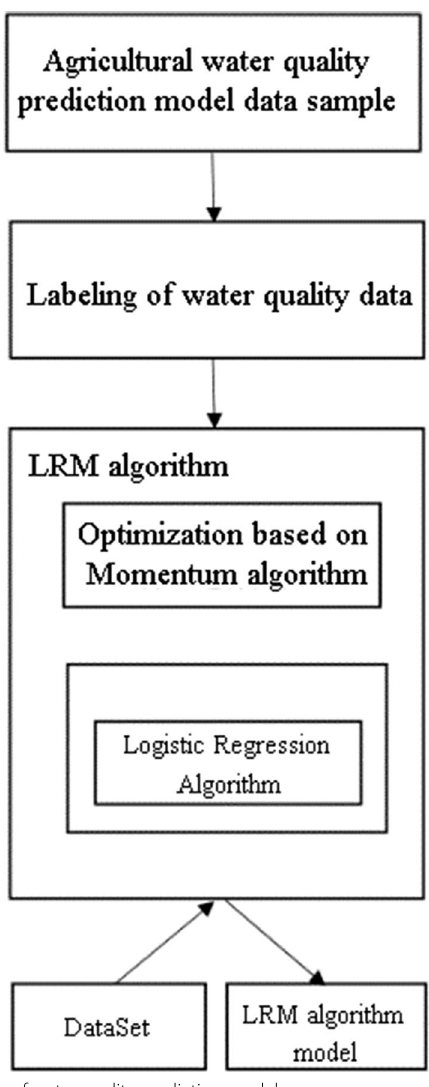
Fig. 4 Architecture diagram of water quality prediction